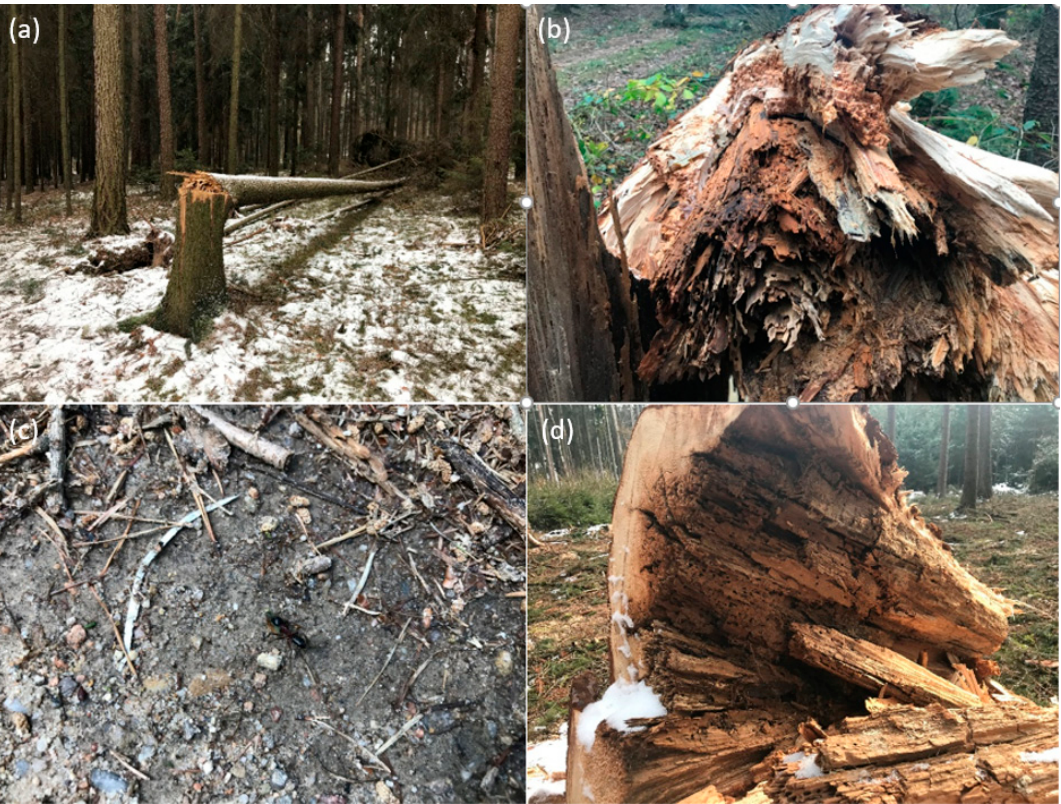
Figure 2. Snapped Norway spruce ( Picea abies (L.) Karst.) tree ( a ). Structure of wood affected by the carpenter ant ( Camponotus ligniperdus ) in the snapped stem of the Norway spruce ( b ). Worker of the carpenter ant with its prey, observed in the late spring ( c ). Cut snag of the Norway spruce infested with a large nest of carpenter ant ( d ) in the East Bohemian woodlands, Czech Republic.